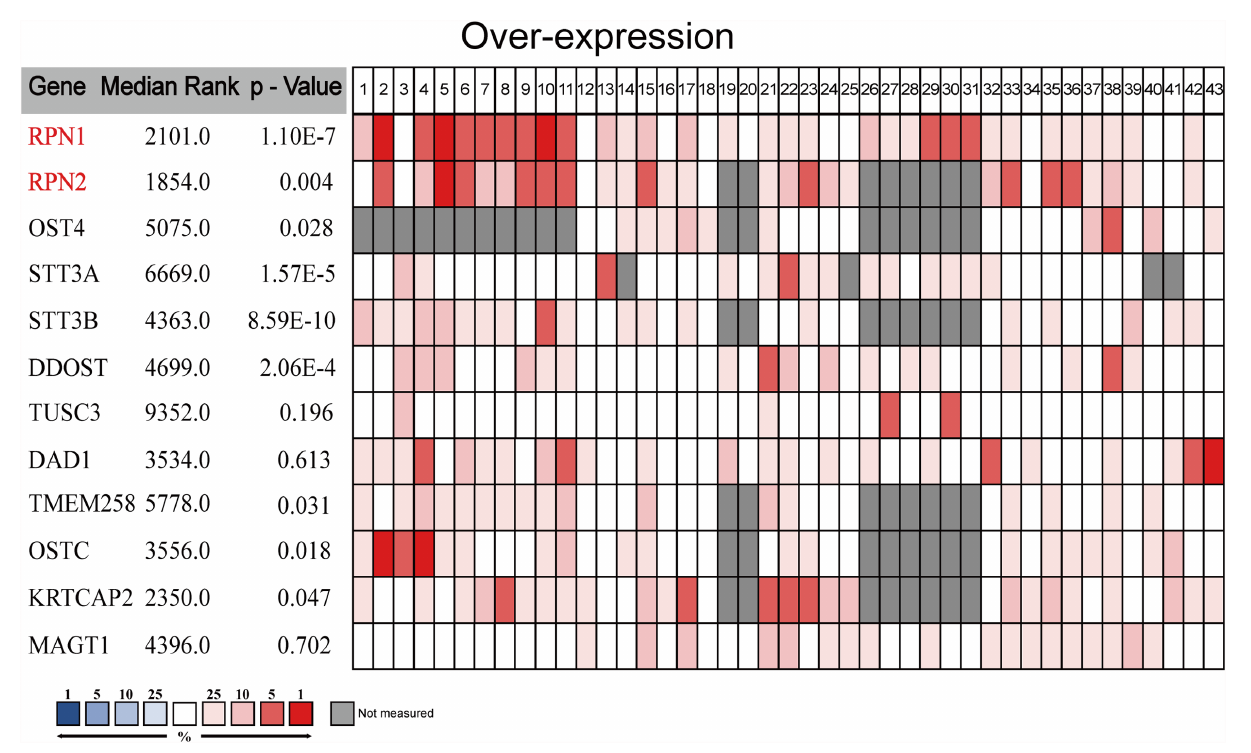
FIGURE 3 | The meta-analysis on the mRNA expression of OST subunits (Oncomine). The comparison of OST subunit mRNA expression in different datasets. Only the upregulated subunits were listed. The rank for a gene was the median rank for that gene across each of the analyses. The p-value for a gene was its p-value for the median-ranked analysis, and p<0.01 was considered statistically signi fi